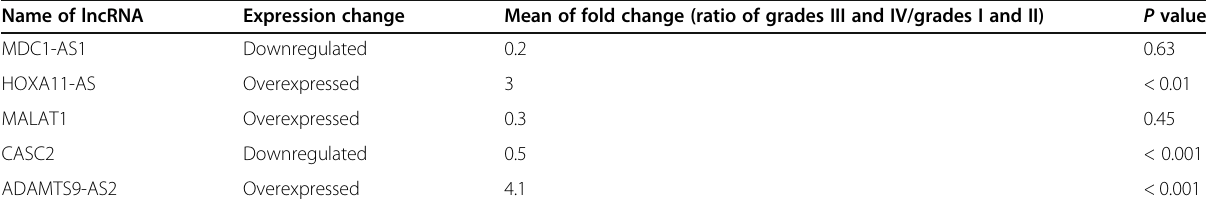
Table 3 The expression of target genes in low- and high-grade glioma tumor tissues Name of lncRNA Expression